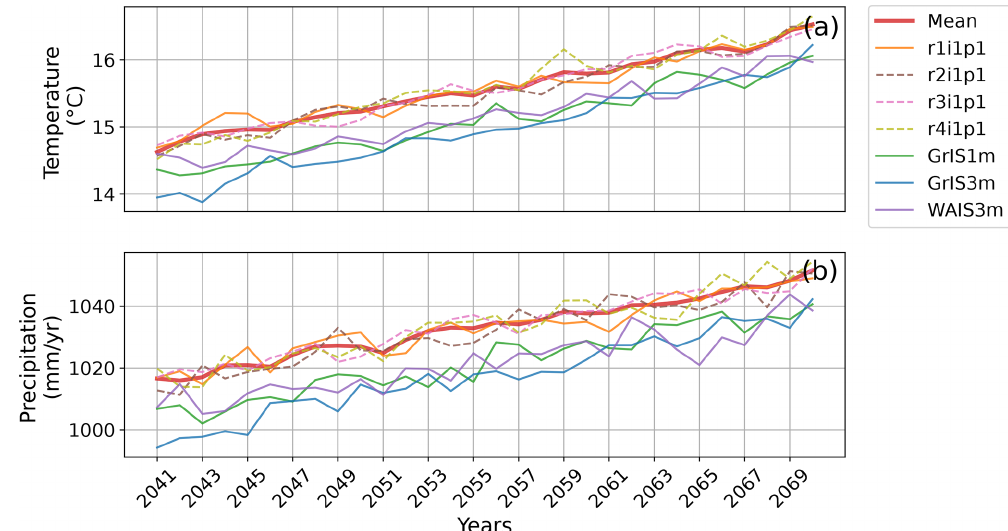
Figure A2. Temporal evolution of (a) temperature and (b) precipitation over the future period (2041–2070) for the different RCP8.5 runs (r1i1p1, r2i1p1, r3i1p1, r4i1p1) and for the different ice melt simulations (GrIS1m, GrIS3m, WAIS3m). The solid orange line depicts the RCP8.5 simulation used in the study. The thick red line shows the ensemble mean of all RCP8.5 simulations from r1i1p1 to r4i1p1.